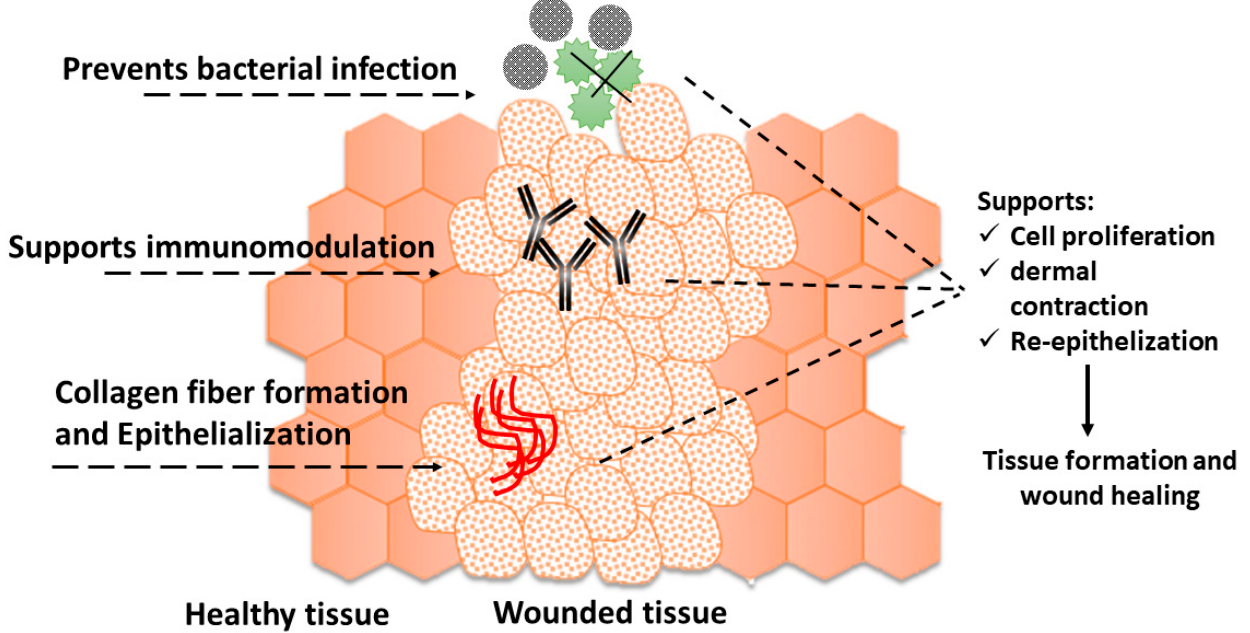
Figure 4. Various hypothetical mechanisms followed by AgNPs to inhibit bacterial cell multiplication and cause bacterial cell damage by ROS. Mechanisms 1–5 are followed to inhibit cell multiplication, and Mechanisms 6–8 cause cell